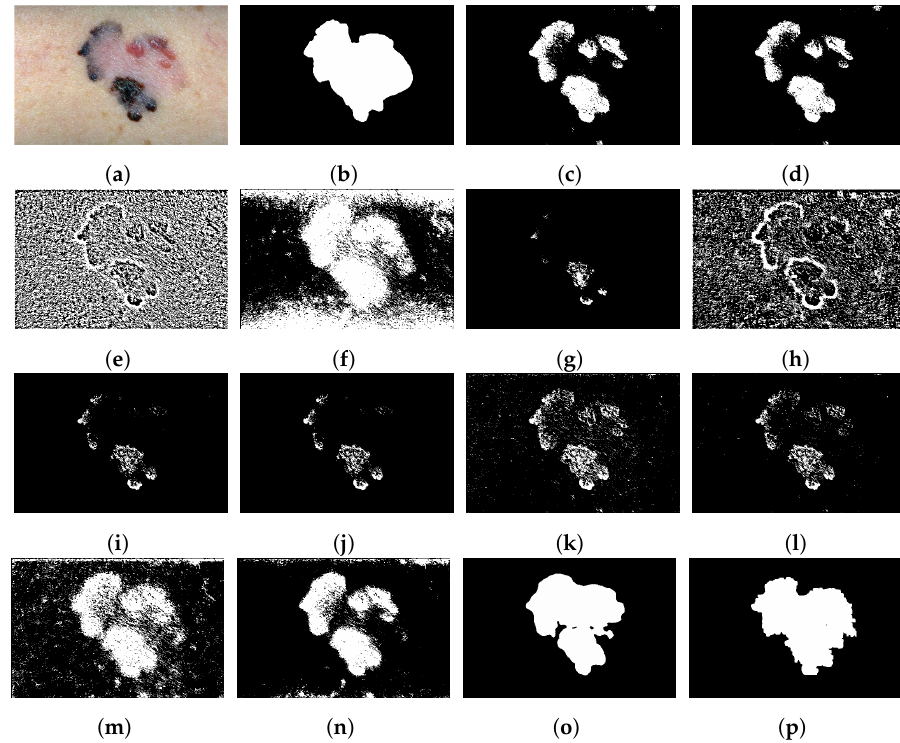
Figure 5. Sample thresholding results using a skin lesion image: ( a ) input image, ( b ) ground truth, ( c ) Otsu [11], ( d ) Kapur et al. [12], ( e ) Niblack [23], ( f ) P-tile [27], ( g ) two-peak [27], ( h )